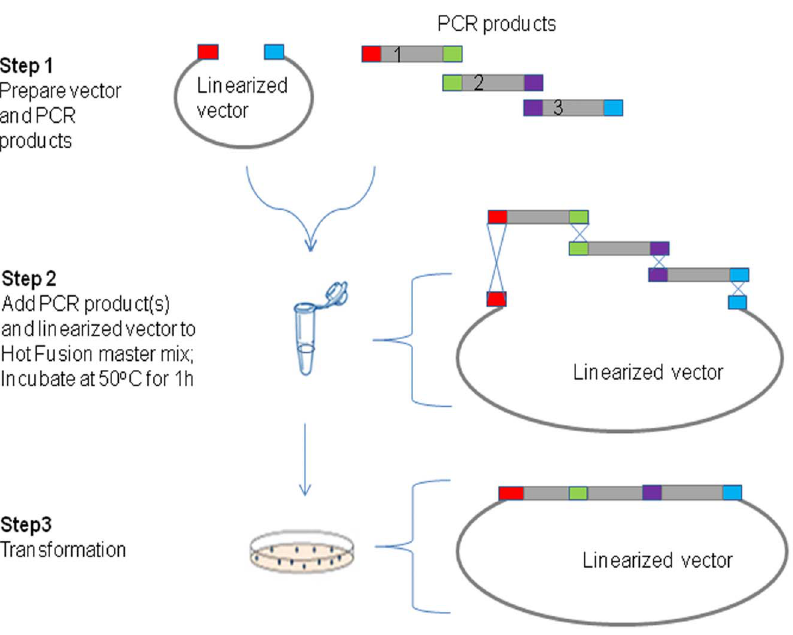
Fig. 2. A diagram of the Hot Fusion process for multi-fragment assembly. Red, green, purple and blue boxes on the vector and PCR products indicate overlapping sequences (25–30